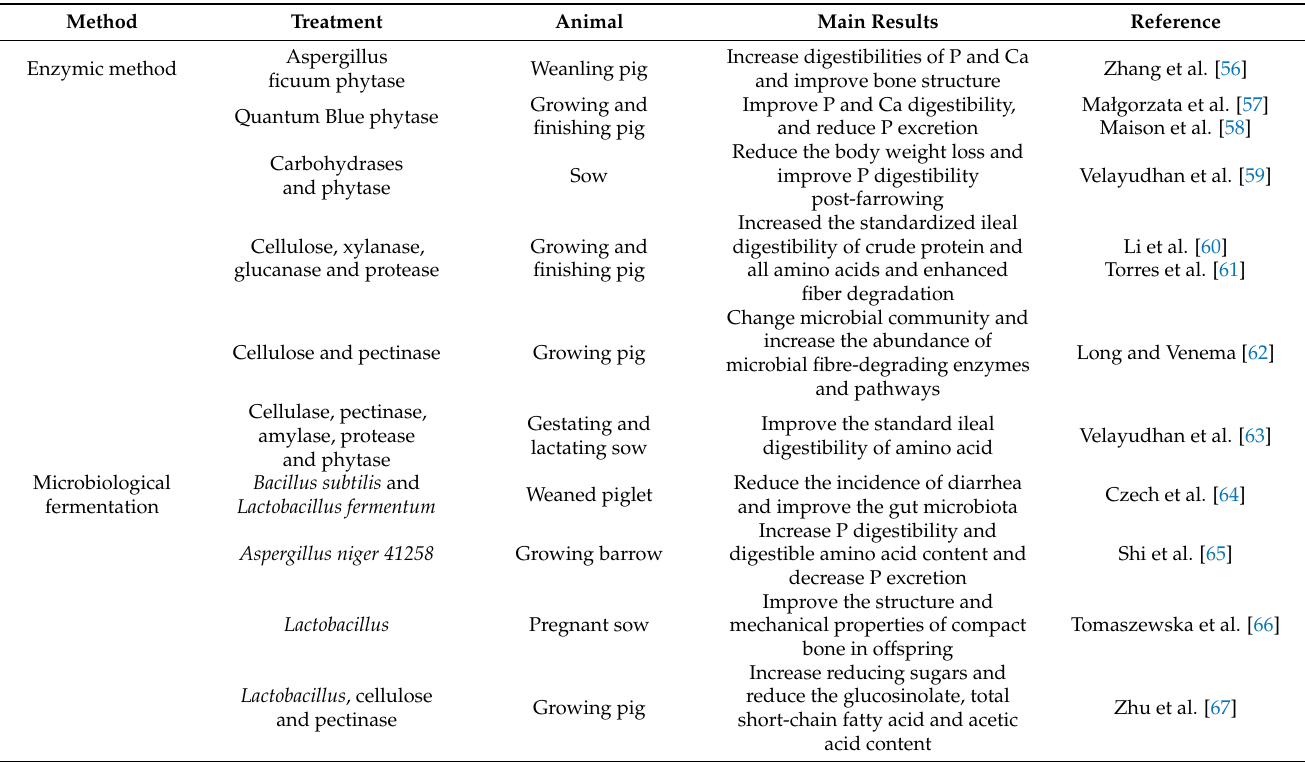
Table 2. Biological method application of rapeseed meal on